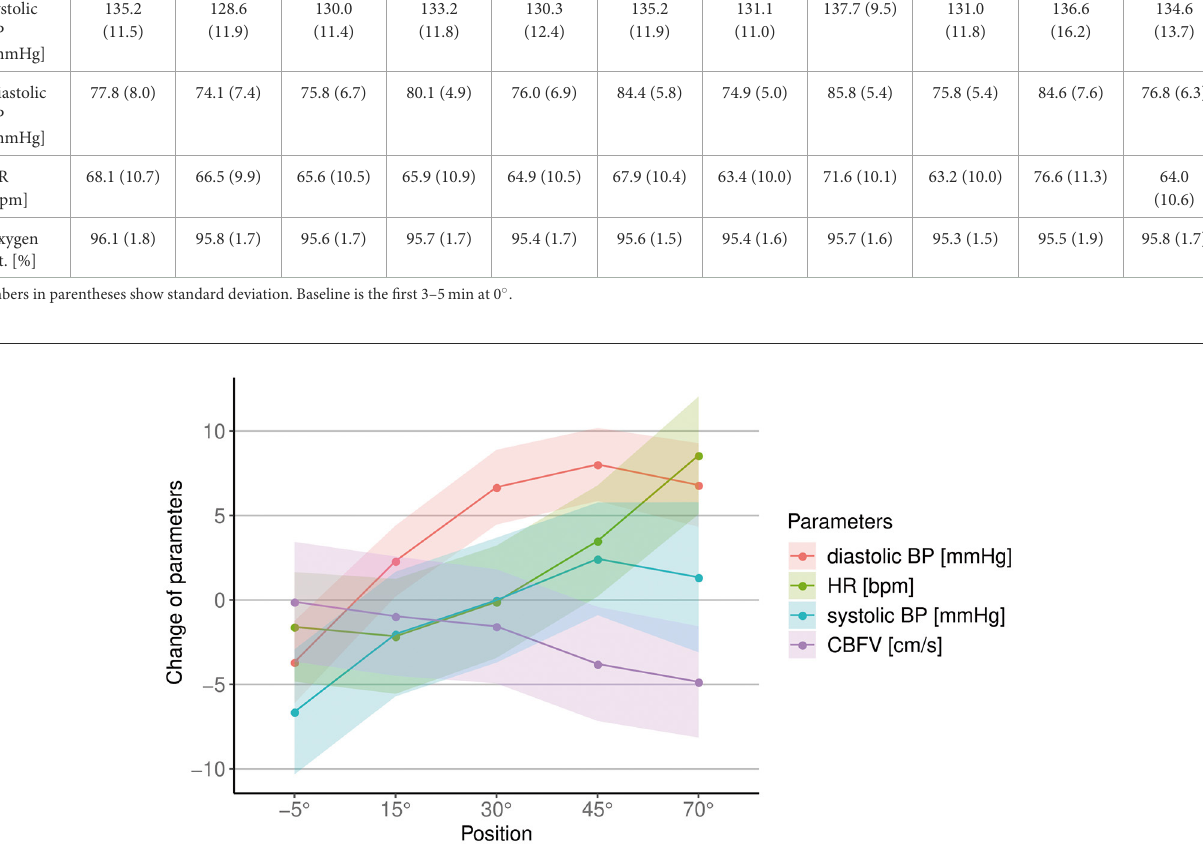
systolic BP ( 1 = − 6.6 mmHg ± 5.1 mmHg SD, p < 0.001), diastolic BP ( 1 = − 3.7 mmHg ± 3.7 mmHg SD, p = 0.004)